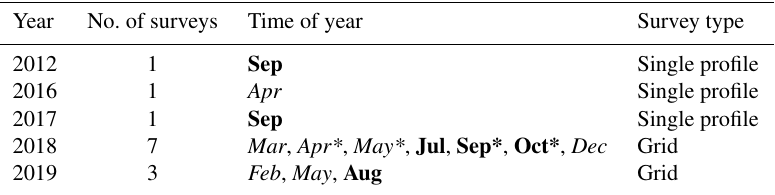
Table 1. Overview of the GPR surveys acquired over the englacial conduit network. Survey months in italic and bold represent the winter (snow-covered) and summer (snow-free) acquisitions respectively, and the asterisk marks the months where common midpoint measurements were additionally